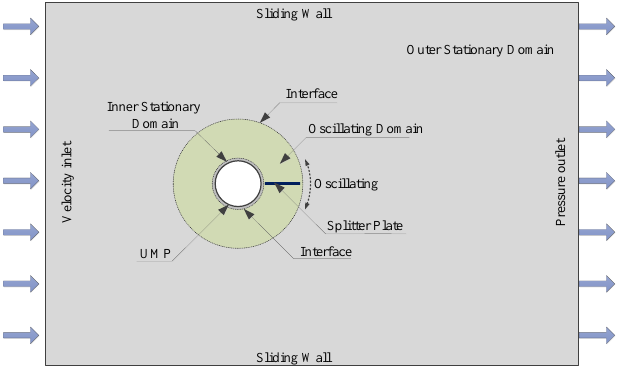
Figure 4. Domains and boundary conditions.